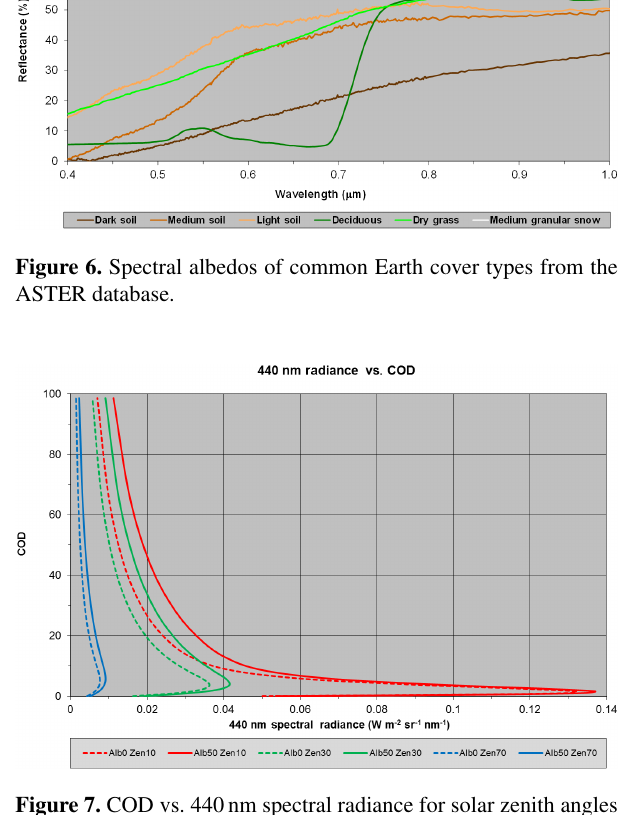
Figure 7. COD vs. 440nm spectral radiance for solar zenith angles of 10, 30, and 70 ◦ and for ground albedos of 0 and